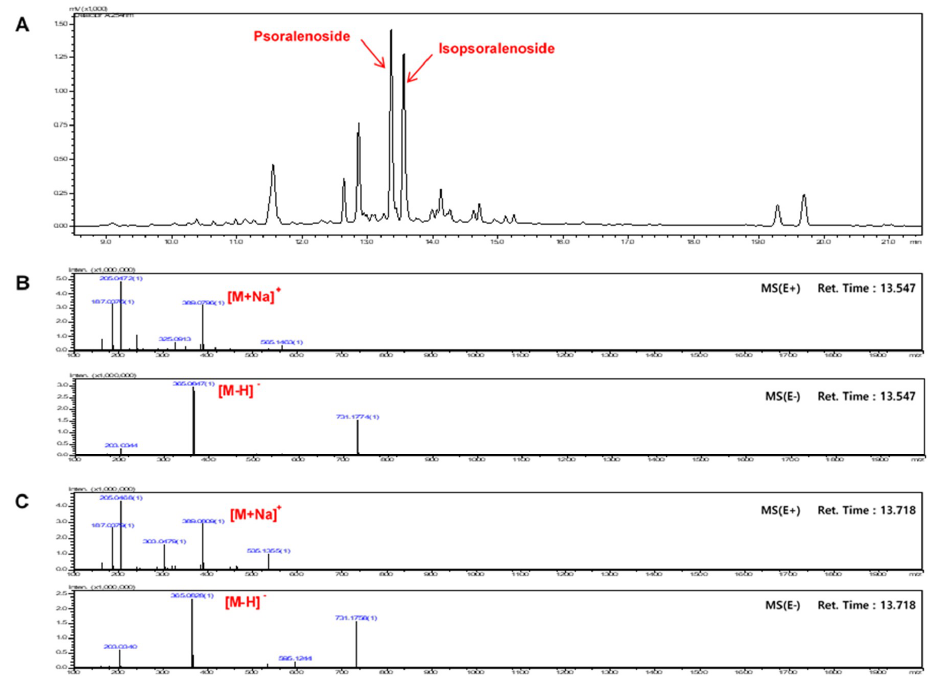
Figure 2. Ion chromatogram of HBX-5. ( A ) Total ion chromatogram and ( B ) MS spectra of psoralenoside ( C ) isopsoralenoside in HBX-5.